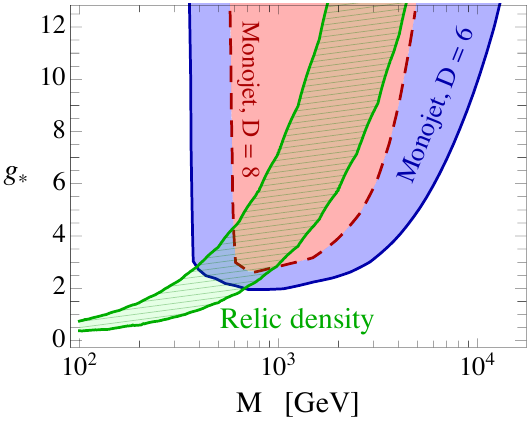
Figure 2: Same as in Fig. 1, but for fermionic Dirac DM. The region shaded in green corre- sponds to the observed relic abundance (fermionic DM comes with incertitude about the chiral structure of the D = 6 effective operator considered [ 8 ] , reflected by the width of the band, contrary to the single line of the scalar